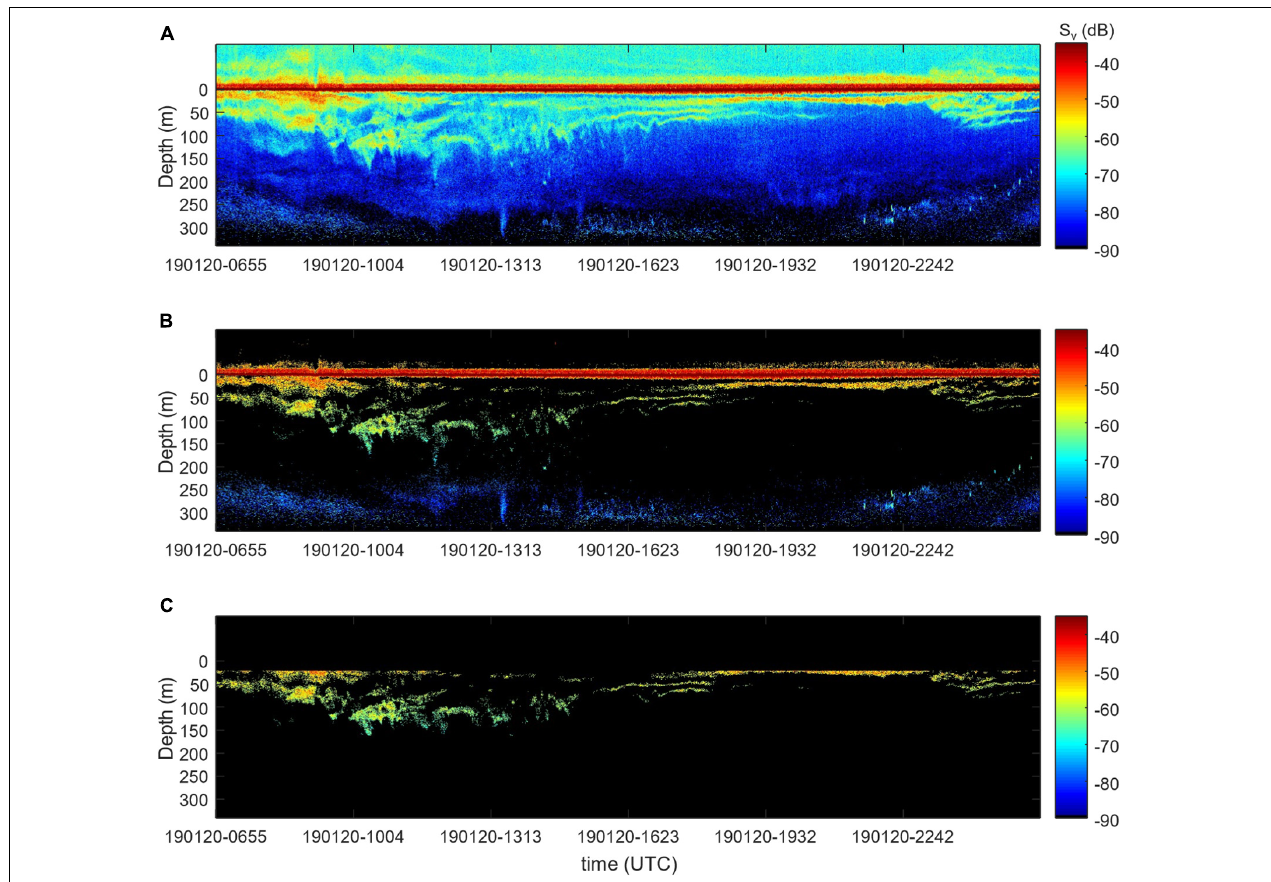
FIGURE 6 | (A) Original S v echogram, (B) denoised, and (C) S v attributed to the krill